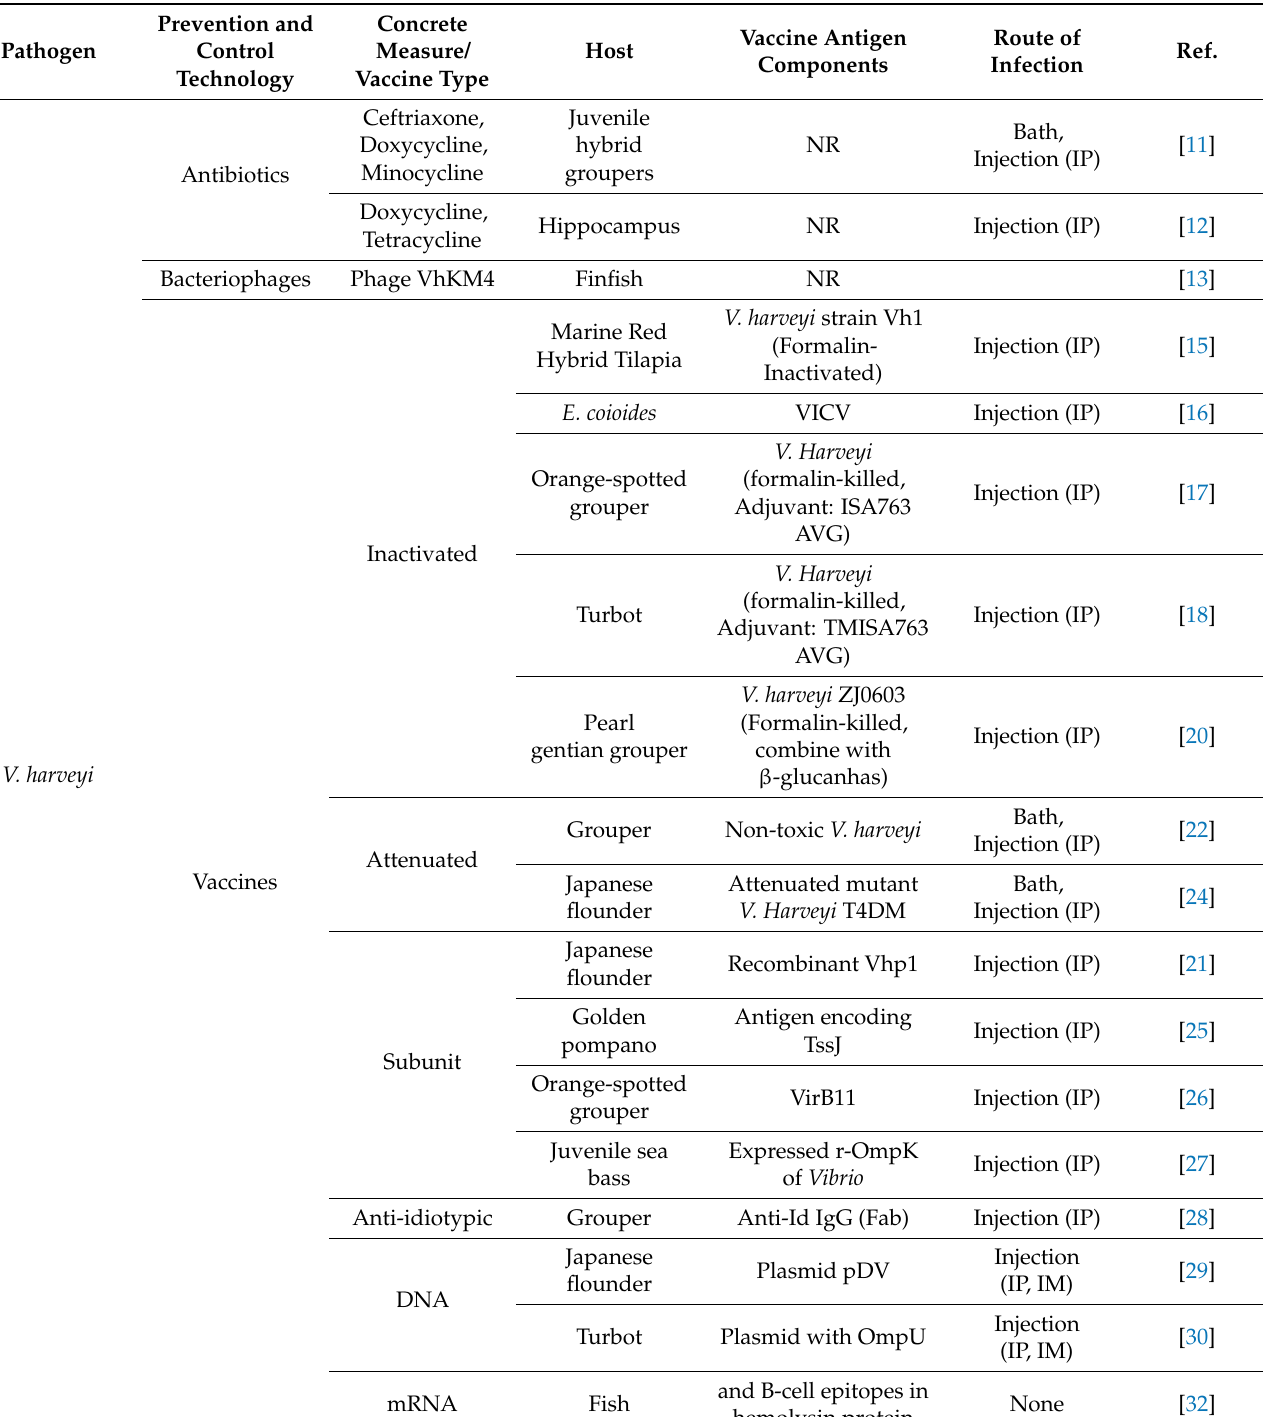
Table 1. Control and prevention strategies of V. harveyi. NR: Not Relevant, None: the method has not been tested in vivo or relevant data has not been